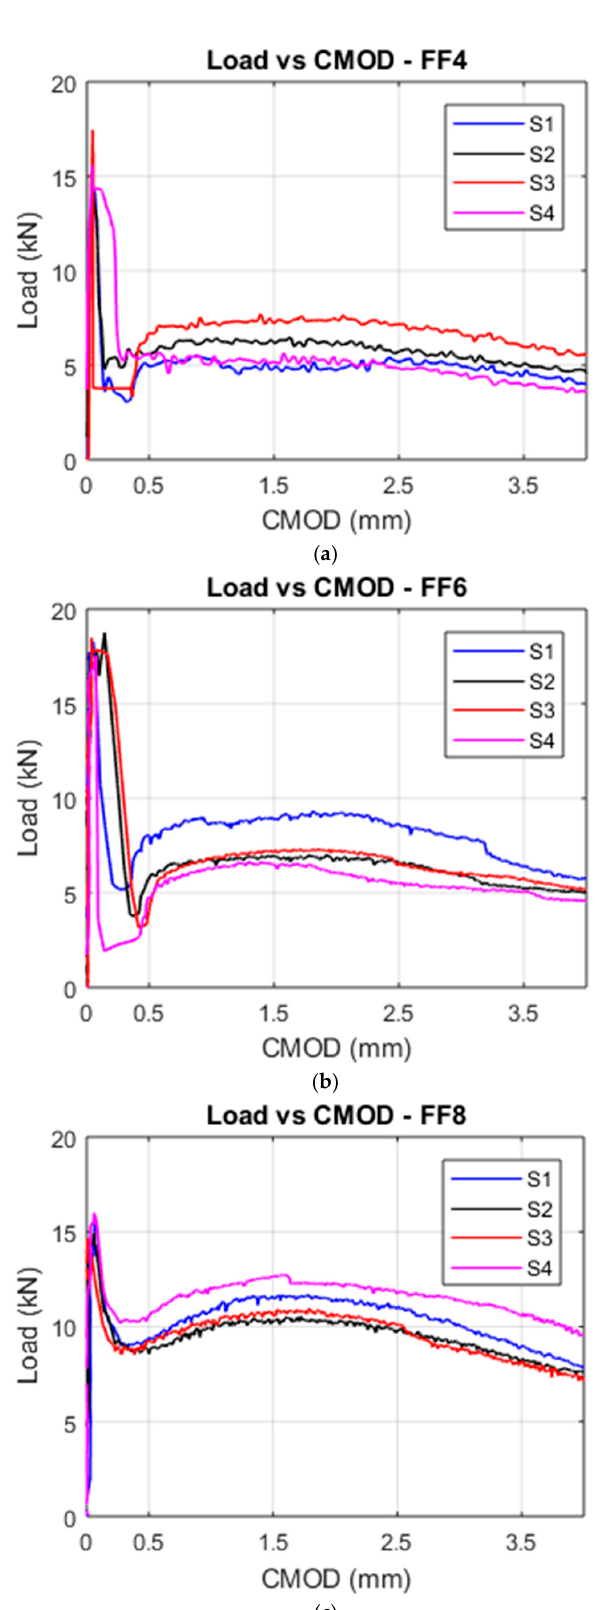
Figure 4. Load vs. crack-mouth opening displacement (CMOD) for ( a ) FF4, ( b ) FF6 and ( c ) FF8.